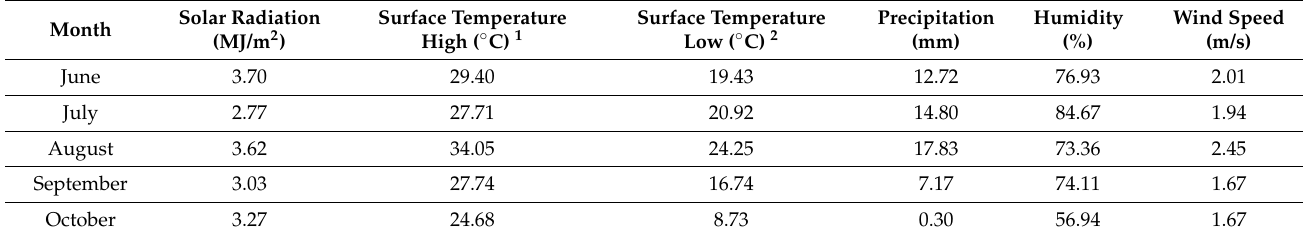
Table 2. Observed climatic data [7].